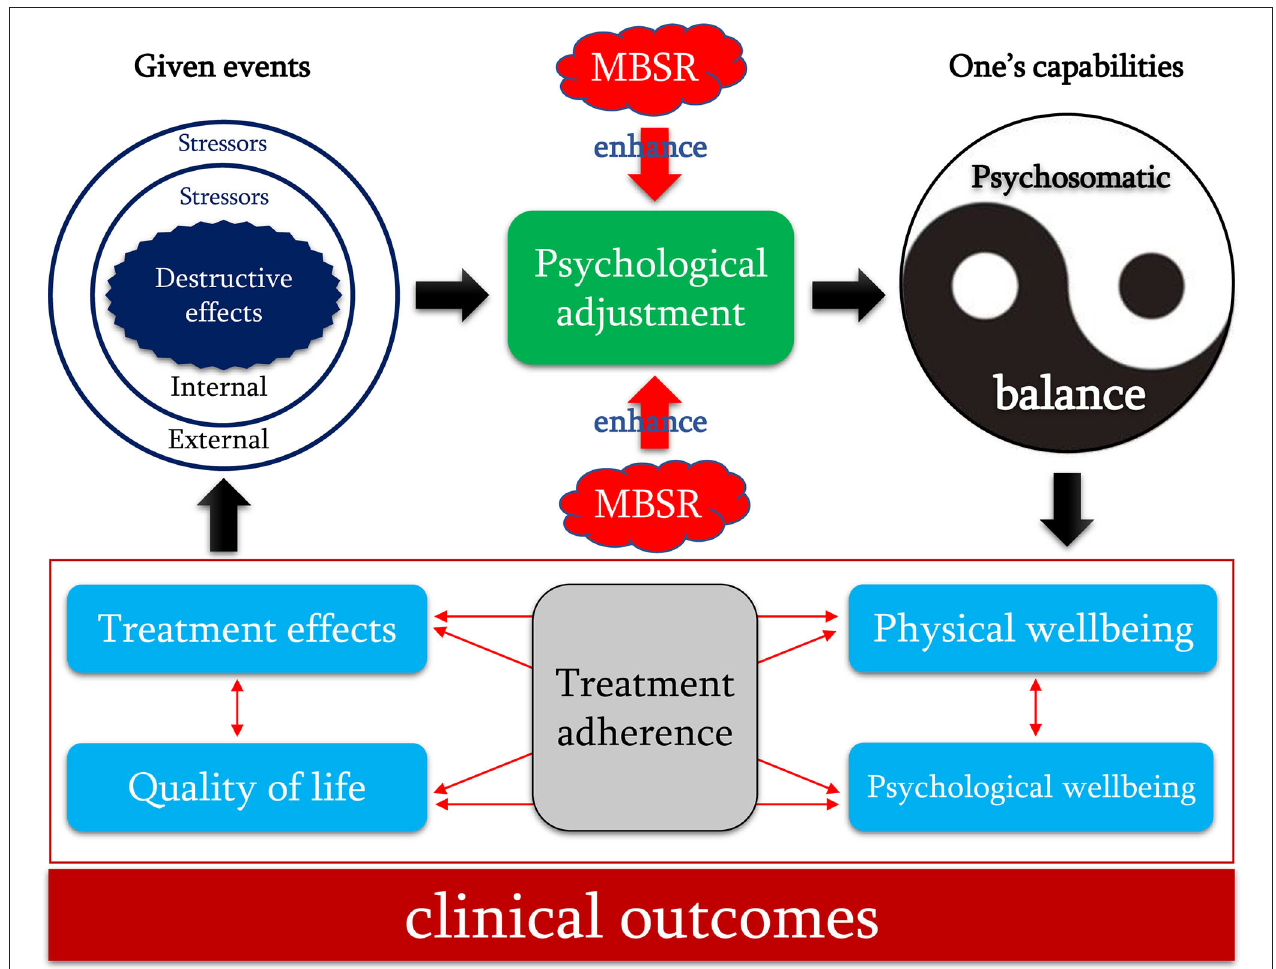
FIGURE 5 | The hypothetical causal pathway of the MSBR program for improving psychological outcomes and QoL of lung cancer patients. MBSR, mindfulness-based stress reduction; QoL, quality of life. In this hypothetical causal pathway, the black unidirectional arrow indicated the causal relationship between two elements, and the red bidirectional arrow indicated the interrelationship of two elements. Destructive effects of stressors break a patient’s psychosomatic balance by initiating negative psychological adjustment and then harming clinical outcomes. In contrast, implementation of the MBSR program may enhance positive psychological adjustment by triggering positive psychological sources (e.g., self-efficacy) to gradually restore the patient’s psychosomatic balance and then improve clinical